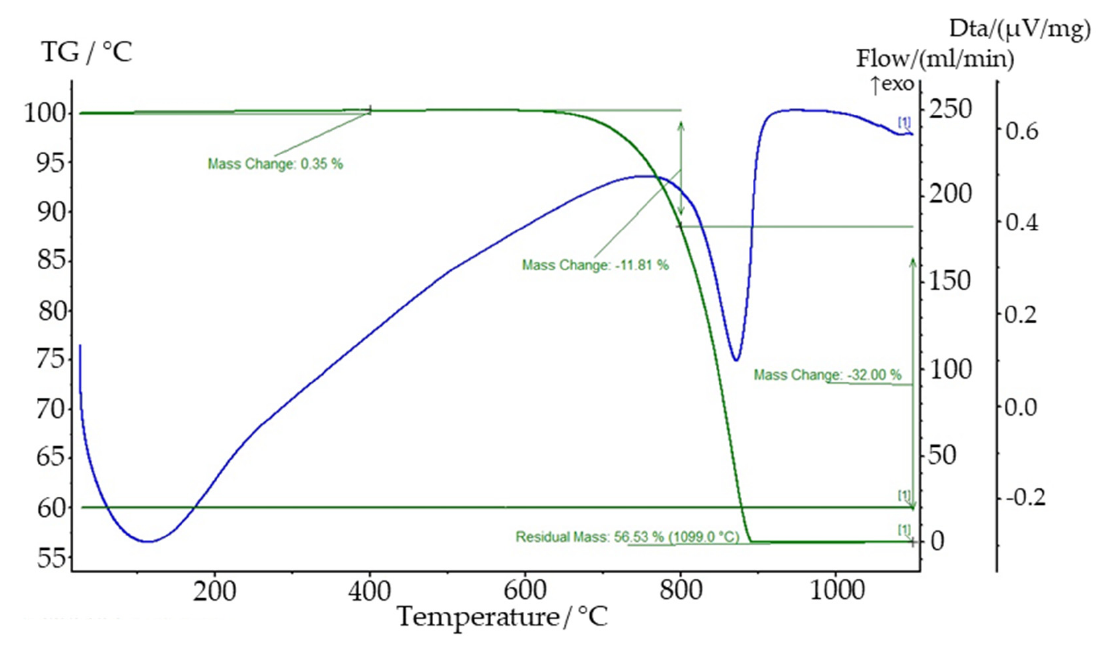
Figure 5. DTA–TGA curves of the calcite concentrate.